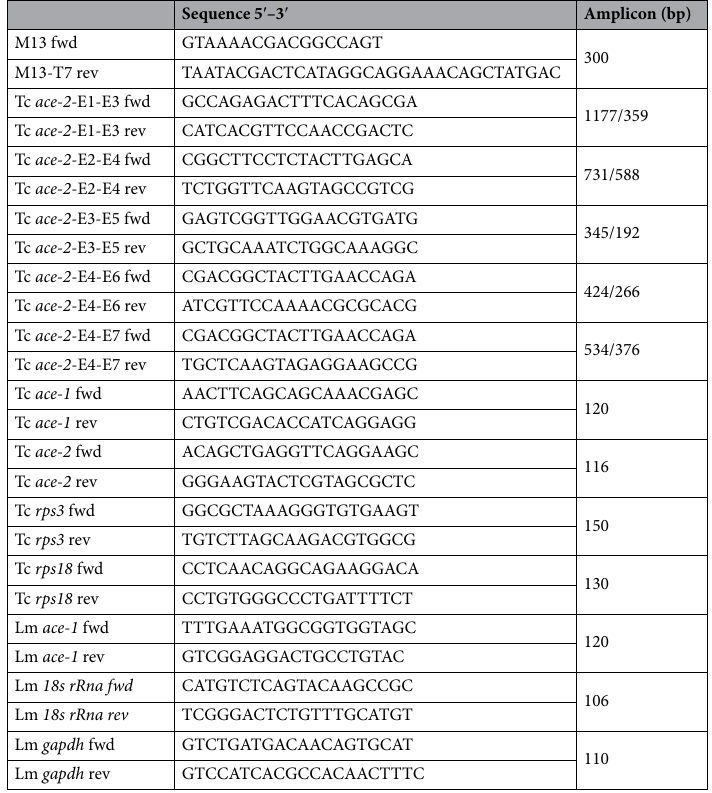
Table 1. Oligonucleotides used in this study. Primers for M13, M13-T7, Lm ace-1, 18srRNA and gapdh were previously used 19,60 . Oligonucleotides used for splice variant analysis of Tc-ace-2 may potentially generate two amplicons. Lm L. migratoria , Tc T. castaneum .